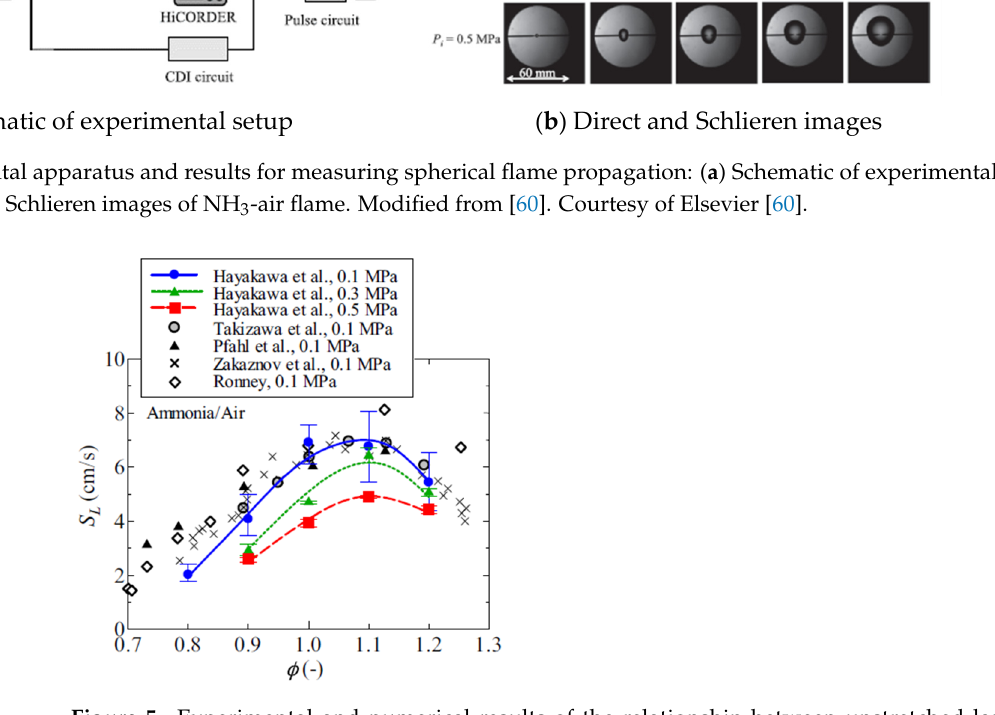
Figure 5. Experimental and numerical results of the relationship between unstretched laminar burning velocity, S L , and equivalence ratio, ϕ . Courtesy of Elsevier